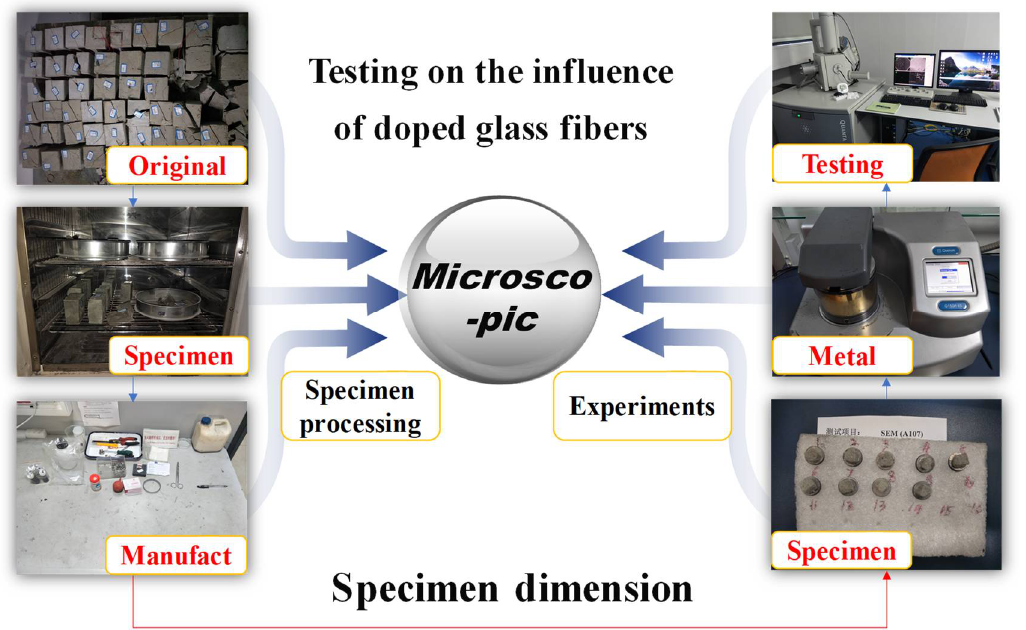
Figure 8. Flowchart of microstructural preparation and observation.